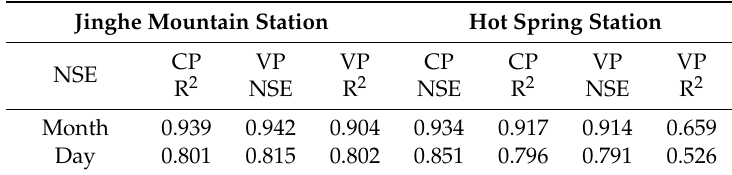
Table 4. The assessment under a monthly and daily scale simulated by the CMADS+SWAT model.